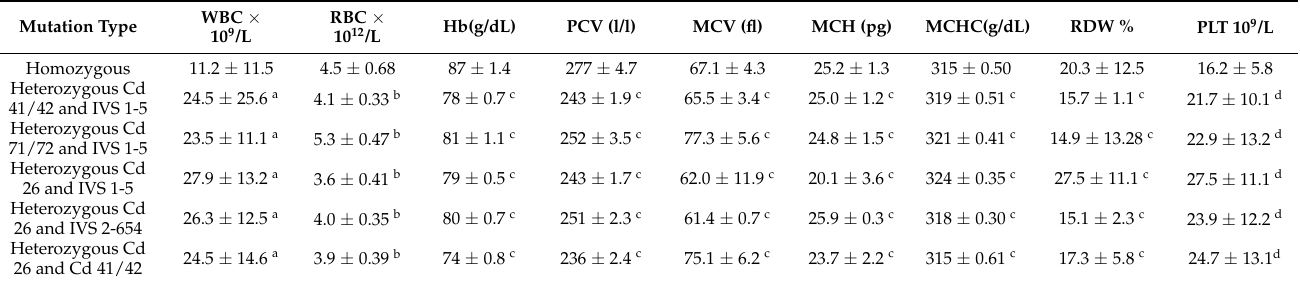
Table 8. Haematological characteristics according to the mutation types of parents (mother/father).